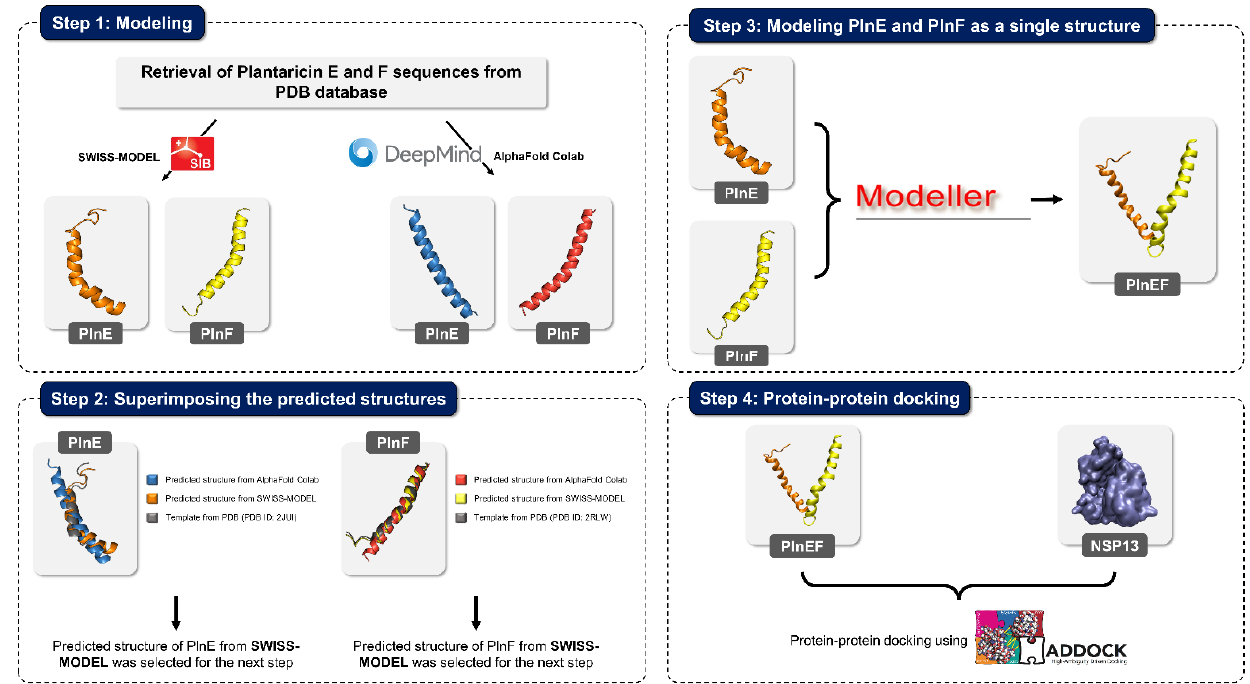
rately [147]. PlnE and PlnF are energetically favorable toward opening the cavity at both they might produce a synergistic effect which might strengthen the binding affinity. This further supports our postulation earlier [147], in which PlnE and PlnF may potentially serve as the blocker to prevent the binding of the ATP and ssRNA.